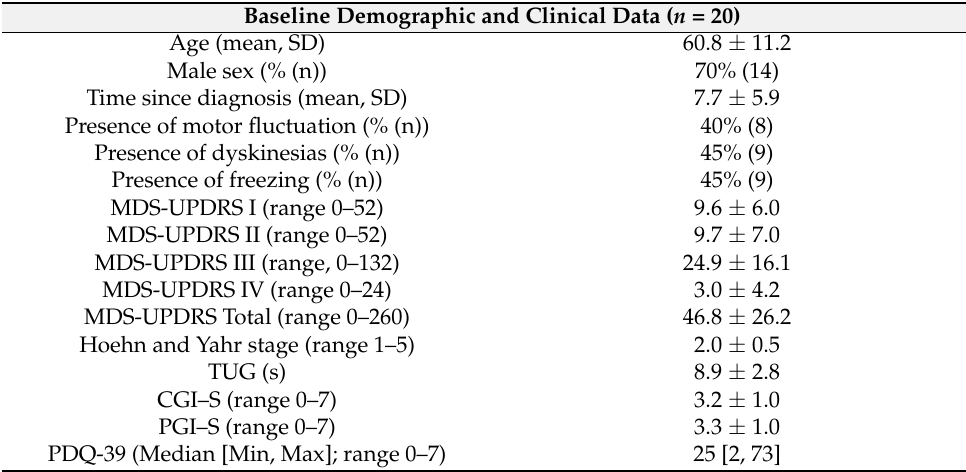
Table 2. Baseline demographic and clinical characterization of a sample. MDS-UPDRS I evaluates the non-motor experiences of daily living, MDS-UPDRS II the motor experiences of daily living, MDS-UPDRS III motor examination, and MDS-UPDRS IV the motor complications.